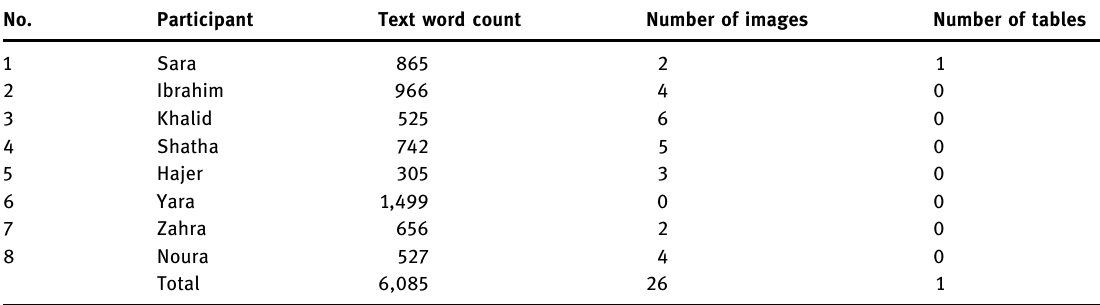
Table 1: A pivot table of the participants ’ texts